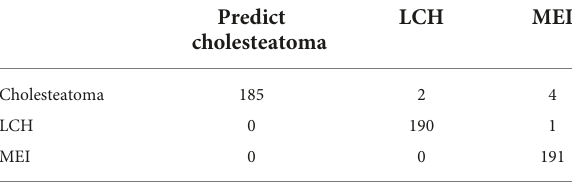
TABLE 1 Multi-classification confusion matrix for deep learning.